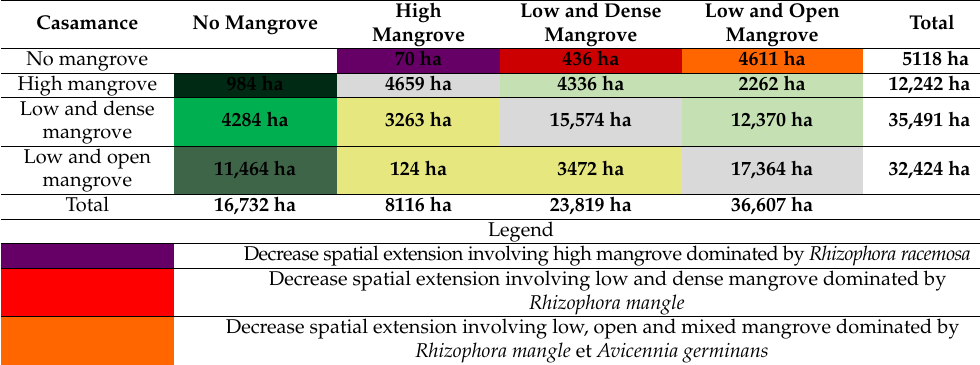
Table 8. Transition matrix for the mangrove zonation class in